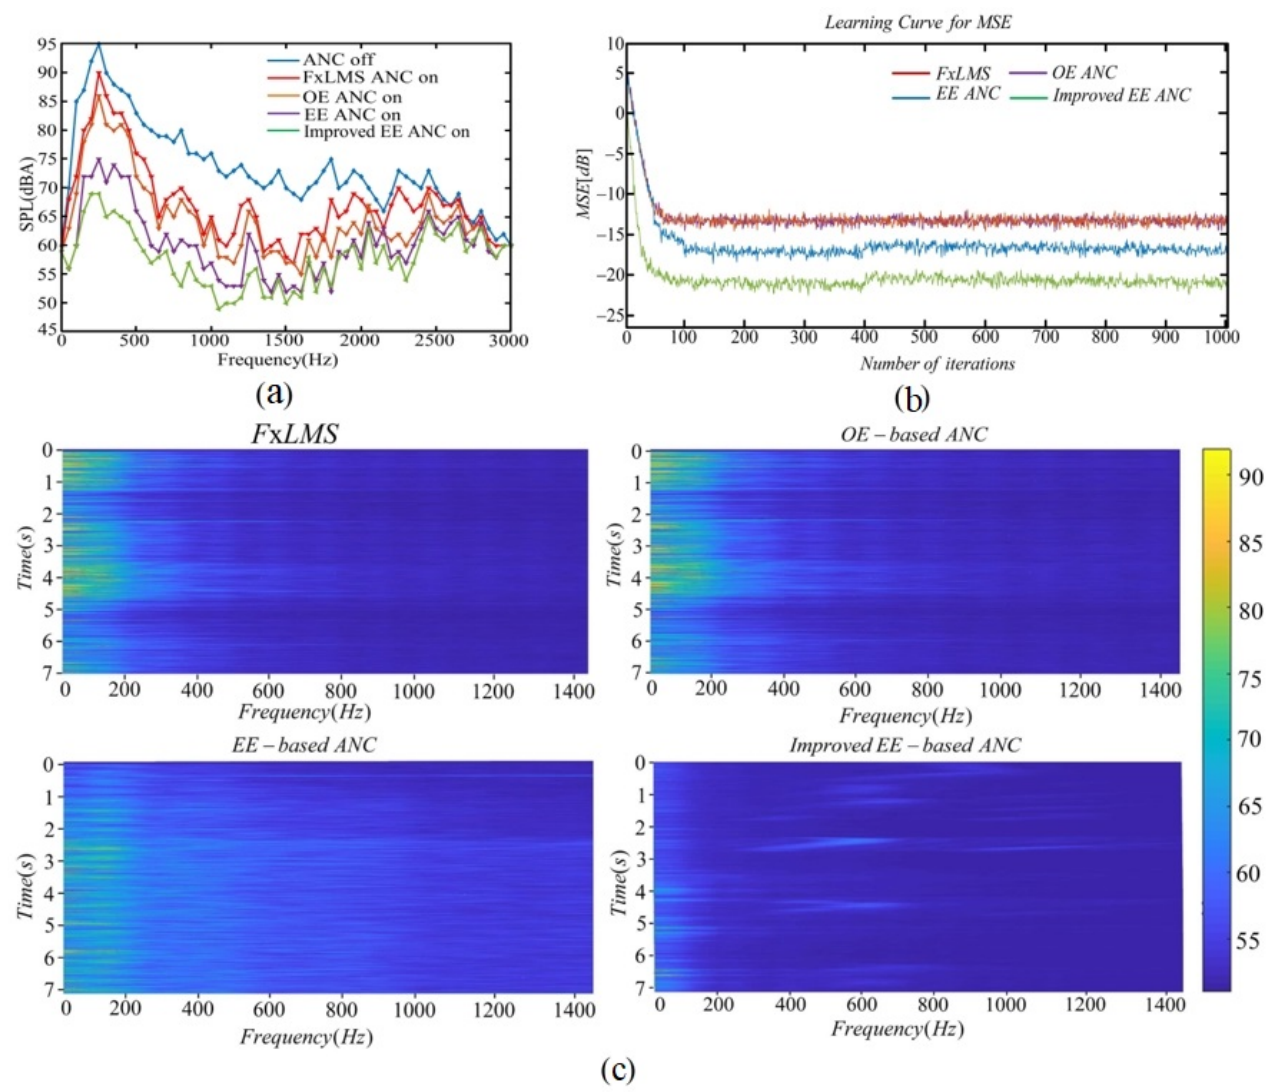
Figure 7. ( a ) Indicates the noise reduction performance comparison of different ANC systems, the ordinate is the A-weighted sound pressure level, and the abscissa is the frequency. ( b ) The convergence process of the mean square error of each algorithm. ( c ) Time–frequency diagram of different algorithms after noise reduction.